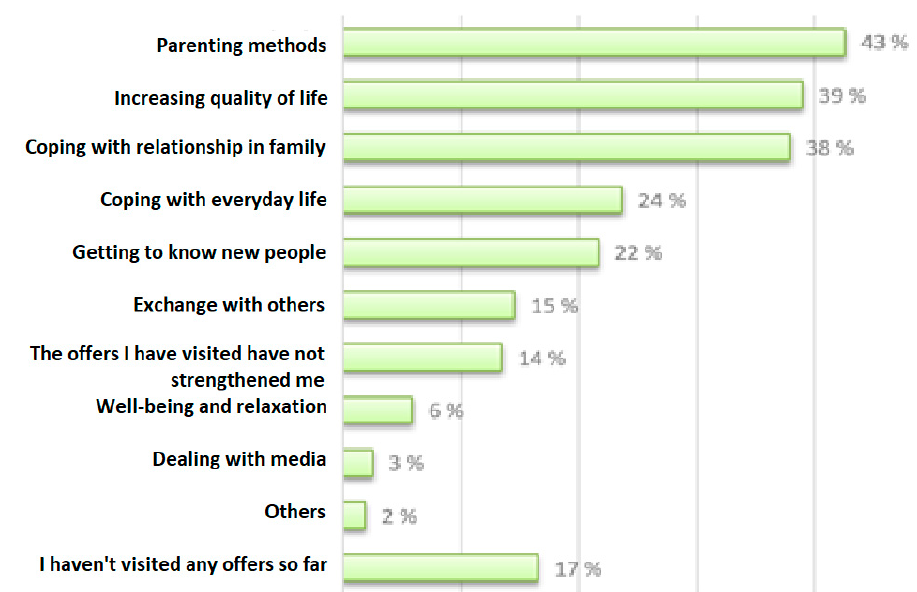
Figure 6. Variables of empowerment for users in family support offers (percentage of all valid multiple answers). (Source: Authors,